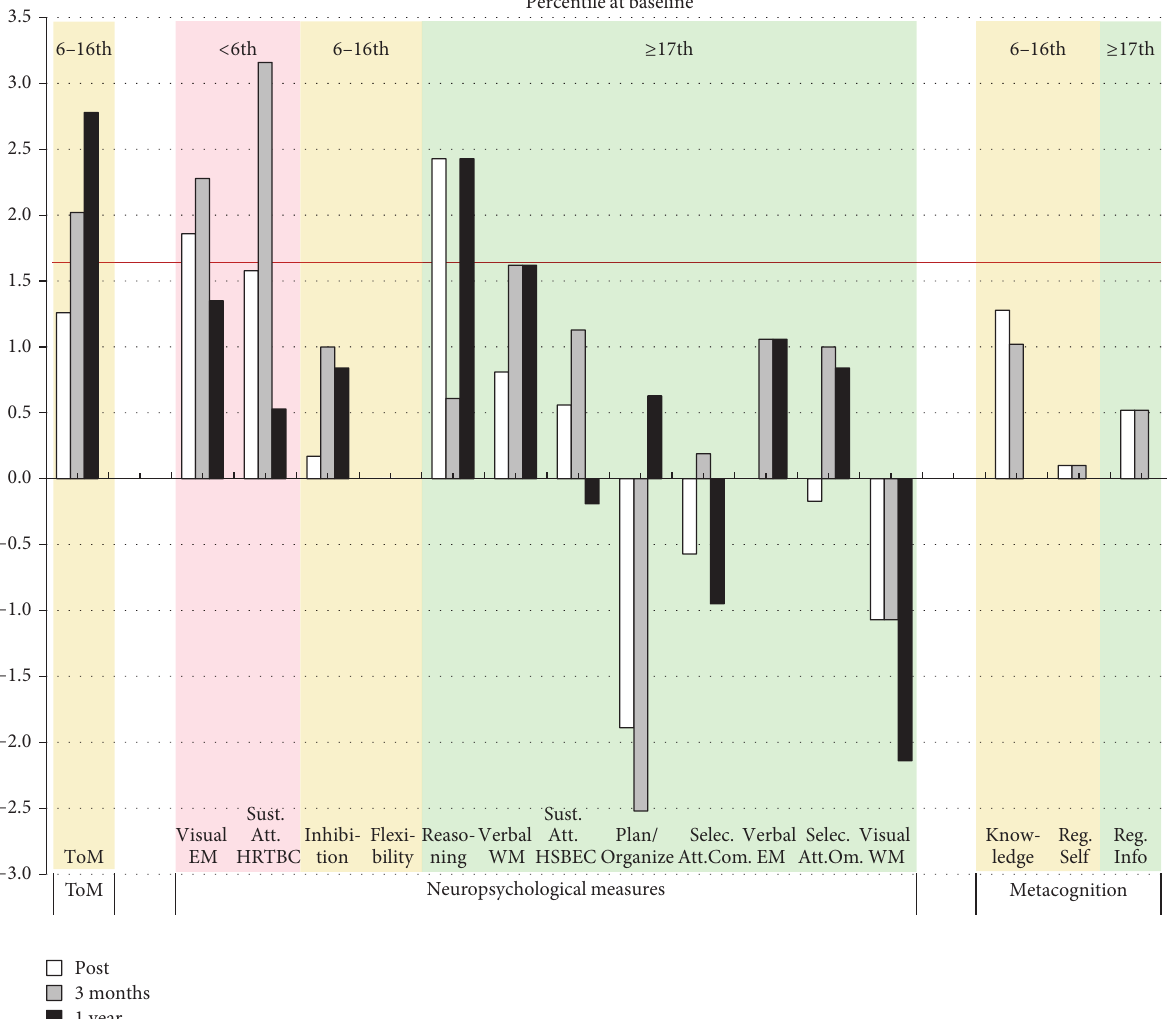
Figure5:ChangesinToMandneuropsychologicalandmetacognitiveresultsforCaseDforeachofthefollow-upassessments(posttreatment, 3 months and 1 year after treatment). The color of the background indicates the severity of the deficit at baseline. A red background indicates a severe impairment at baseline ( ≤ 6th percentile), a yellow background indicates an important impairment (7th to 16th percentile), and a green background indicates a normal performance ( ≥ 17th percentile). The horizontal red line indicates the statistical RCI threshold of 1.64. ToM = theory of mind; EM = episodic memory; sust. att. = sustained attention; HRTBC = Hit Reaction Time Block Change; WM = working memory; HSBEC = Hit Standard Error Block Change; selec. att. = selective attention; com. = commission; om. = omission; knowledge = metacognitive knowledge; reg. self = Metacognitive Regulation Self Report; reg. info = Metacognitive Regulation Informant